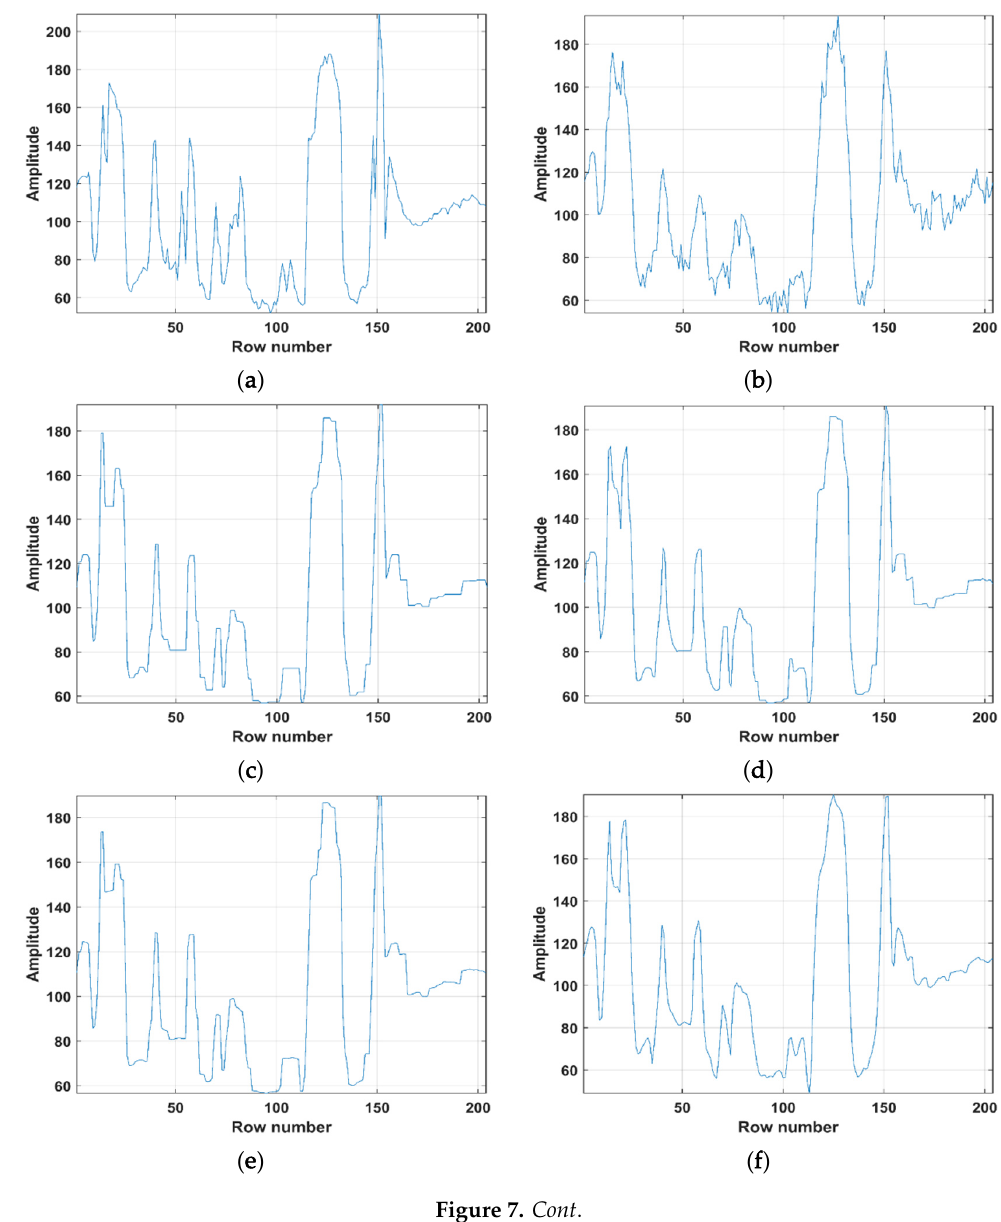
Figure 6. Comparison of the visual effects. (a) is the original “Store” image; (b) is the degraded image with Gaussian blur (G, 5, 5, 7) and Gaussian noise standard deviation of 5; (c–d, i–l) are the deblurring results of ATV, ITV, ATpV, FTV4Lp, Hybrid TV, and HTV-Lp methods, respectively; (e–h, m–p) show the magnified details from the rectangles in (a–d, i–l), respectively.